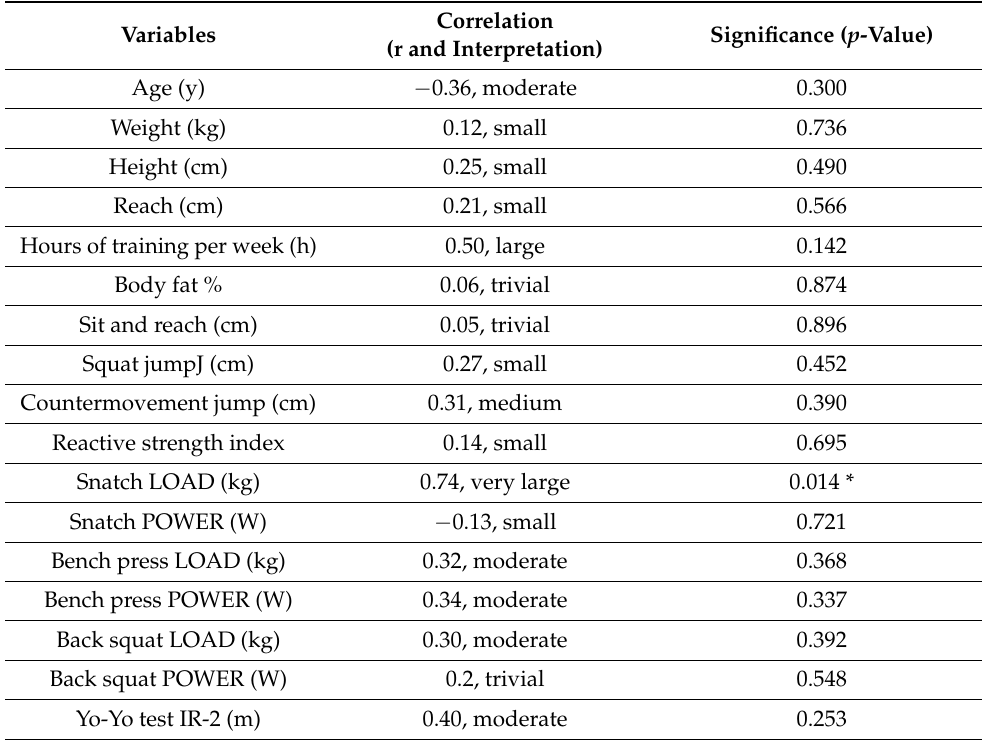
Table 3. Correlation coefficients, interpretation, and significance levels in the variables included in the study.